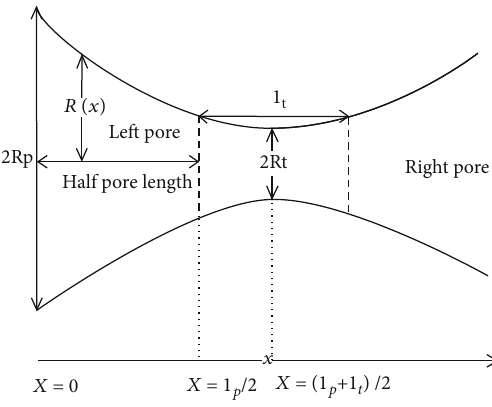
Figure 1: Dimension of the throat structure in the